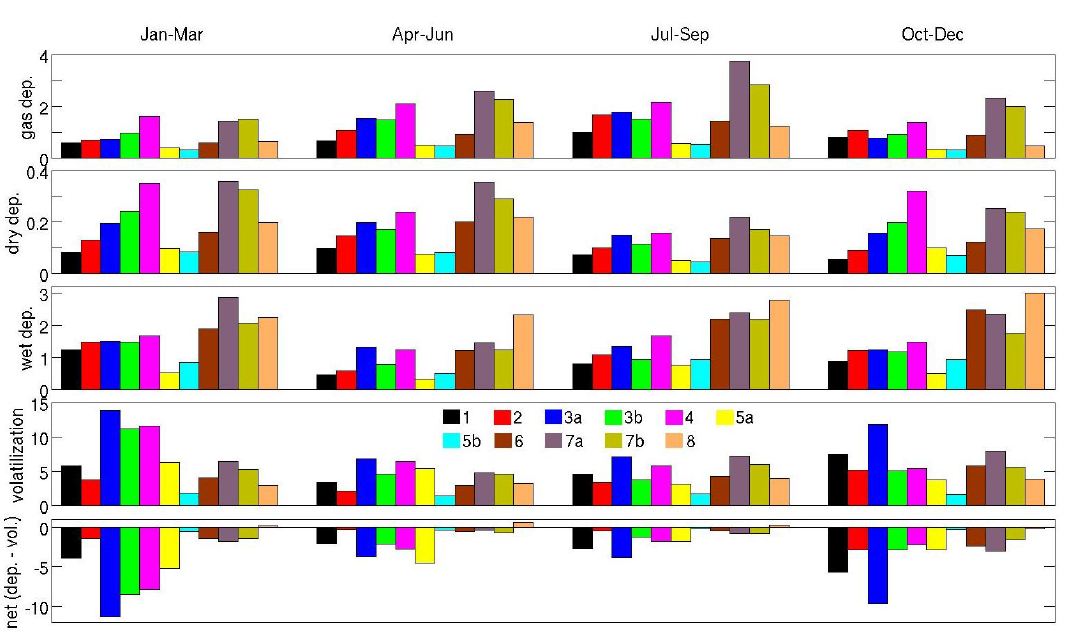
Figure 13. Bar charts of integrated quarterly (3 month) fluxes (kg) by ICES boxes (Figure 1) of PCB 153 in 2004: gas deposition ( top row ), dry deposition ( 2nd row ), wet